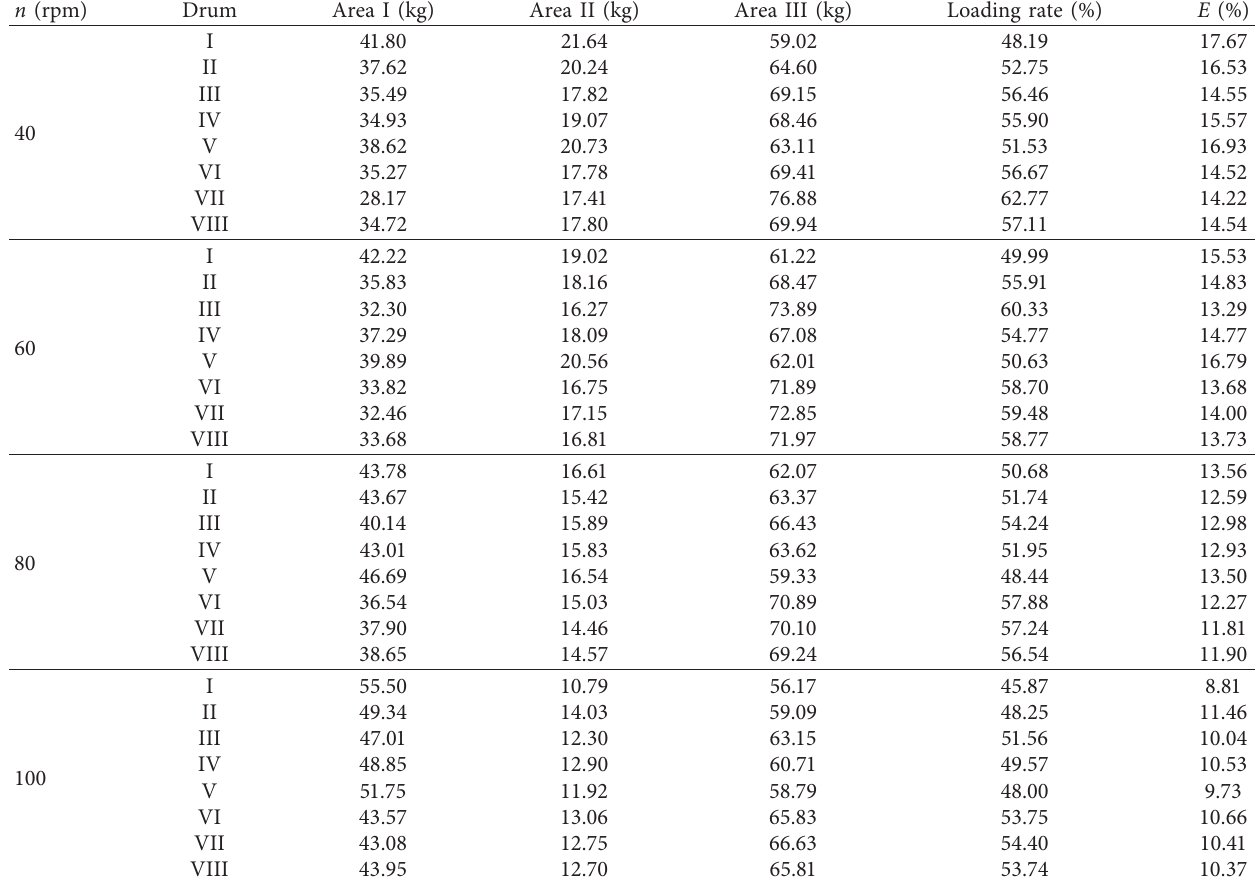
Table 6: The statistical results of coal particle mass in different